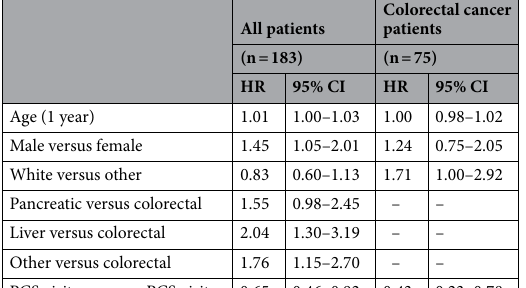
Colorectal cancer patients